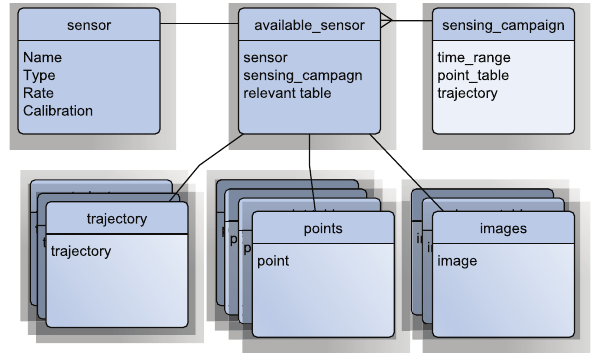
Figure 3: Example of a data model to store metadata. A more realistic data model is given by Hofle (2007, p. 15).